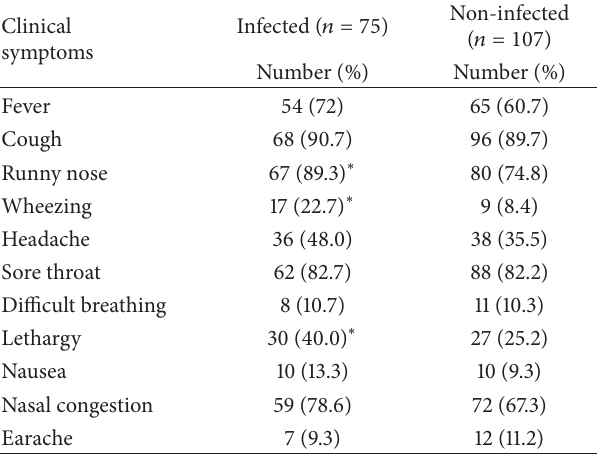
Table 4: Clinical symptoms in infected and noninfected patients. Clinical